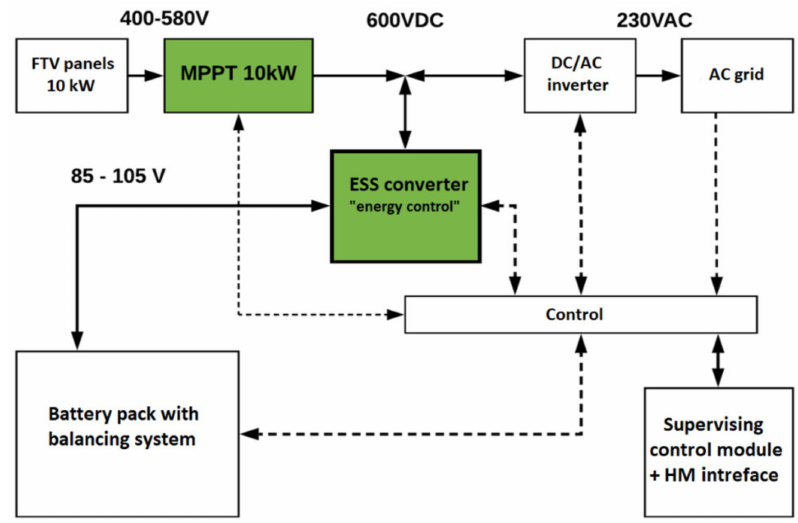
Figure 2. Block diagram of proposed microgrid for households.